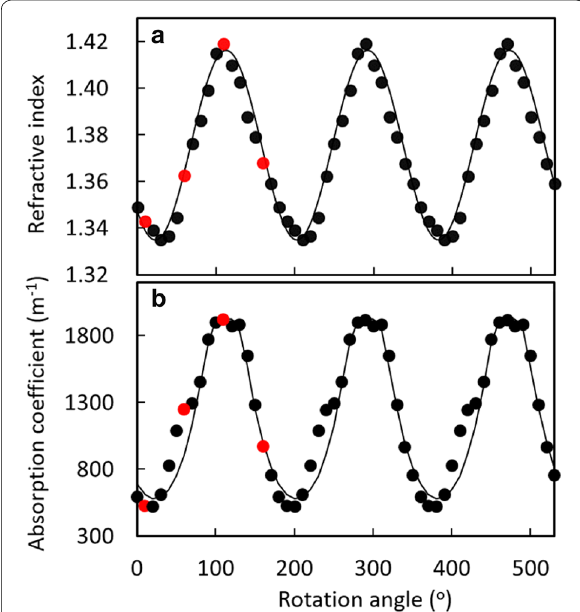
Fig. 2 Relationship between the rotation angle and the measured a refractive index and b absorption coefficient (circles) and simulated values (solid line) of oven-dried Japanese ash (density The data used for the prediction are shown by the red circles